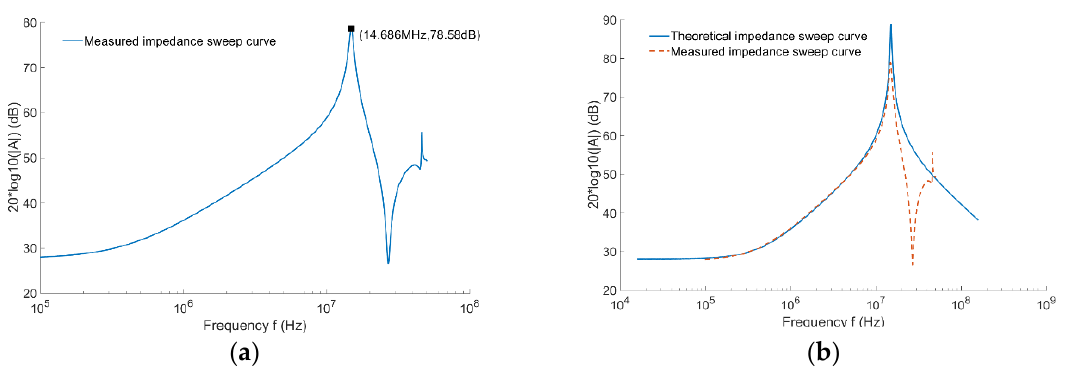
Figure 7. Impedance Sweep Curve. ( a ) Measured Impedance Sweep Curve; ( b ) Theoretical Correction and Measured Anti-Sweep Curve.